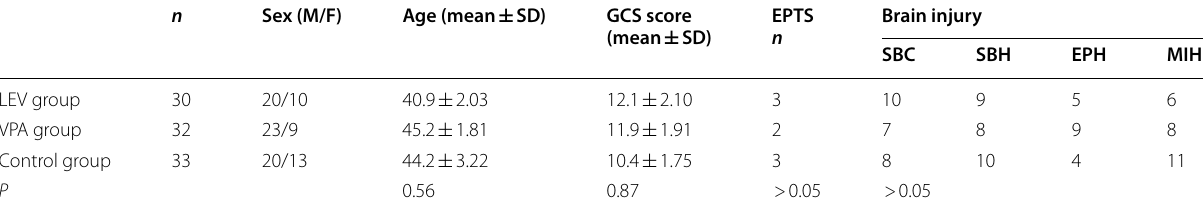
Table 1 Demographics and clinical data of the patients with acute brain